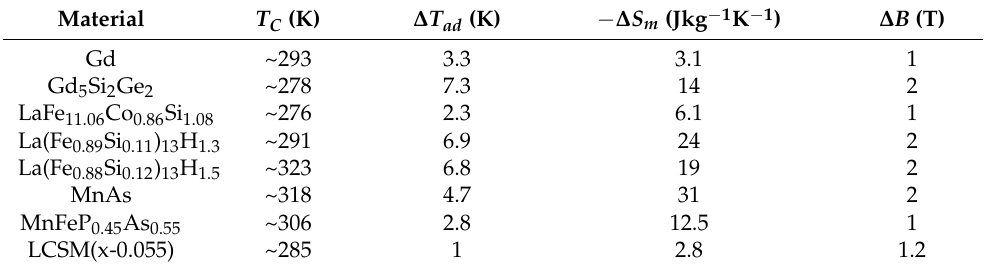
Table 1. Magnetocaloric properties of selected MCMs at near room temperature.